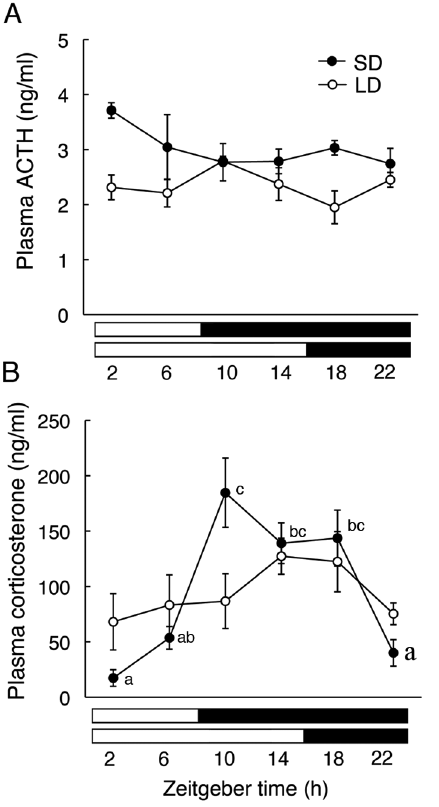
Figure 2. Effects of photoperiod on diurnal fluctuations in plasma ACTH and corticosterone of Fischer 344 rats. Rats were maintained under either short-day condition (SD, 8 h of light, 16 h of darkness, black circles ) or long-day condition (LD, 16 h of light, 8 h of darkness, white circles ) for 2 weeks. Corticosterone levels (A) in rats maintained under SD showed a significant variation throughout 24 h ( P , 0.01, one-way ANOVA), whereas no diurnal variation was detected in those maintained under LD. ACTH levels (B) in rats maintained under LD was constitutively lower than those under SD ( P , 0.01, two-way ANOVA). Different characters indicate significant differences among time points within the SD ( P , 0.05, one-way ANOVA followed by Bonferroni’s multiple comparison test). The black and white bars below the graphs show the length of the dark and light phases. Values are means 6 SEM (n=4–5). doi:10.1371/journal.pone.0039090.g002 in which the CRH-induced level was 81% of the control. When the levels were compared between animals exposed to long- and short-day conditions, they did not differ significantly ( P . 0.05)